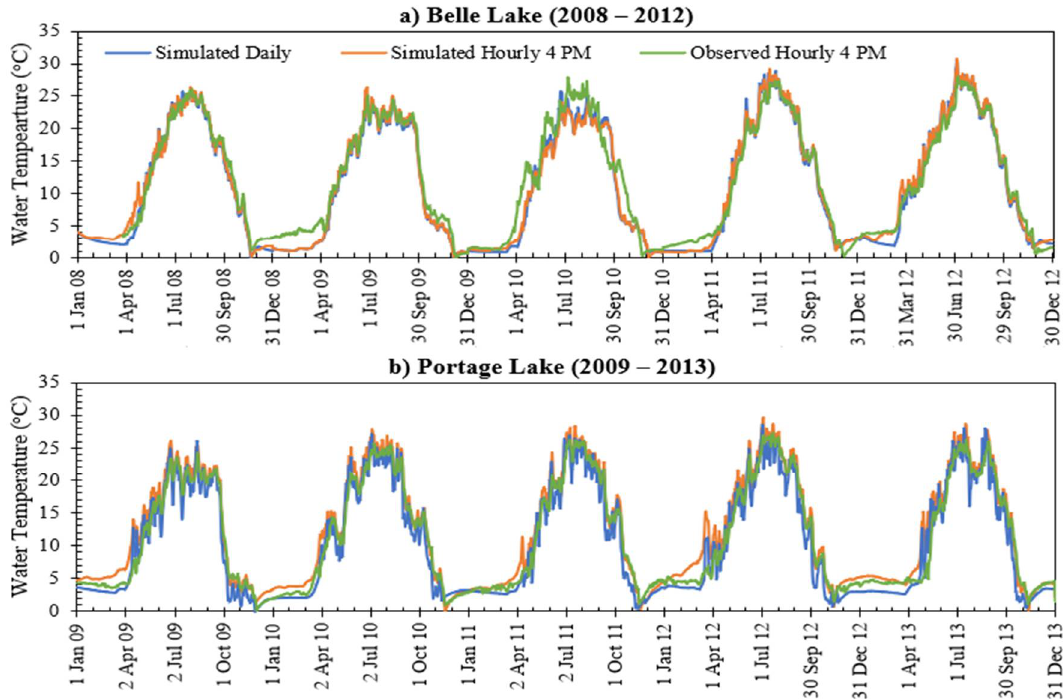
Figure 4. Time series of simulated daily, simulated and observed hourly surface (1 m at Belle and 1.5 m at Portage Lake) temperatures at 4 PM at Belle Lake (2008–2012) and Portage Lake (2009–2013).